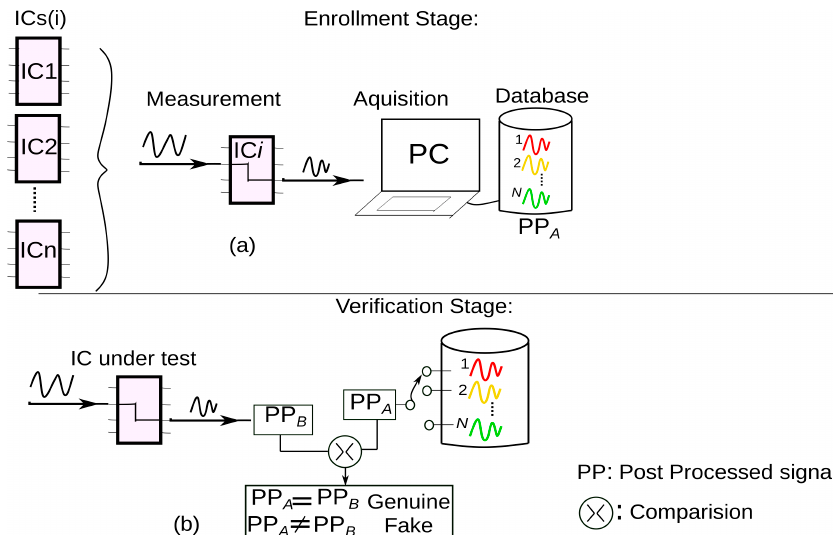
Figure 2. A depiction of different steps involved in the authentication procedure, implemented using guided wave approach. ( a ) Enrollment stage, which generates the database before IC is sent to the end users. ( b ) Verification stage: End users or customers who want to check for authenticity of the ICs they have. PP = post-processed.